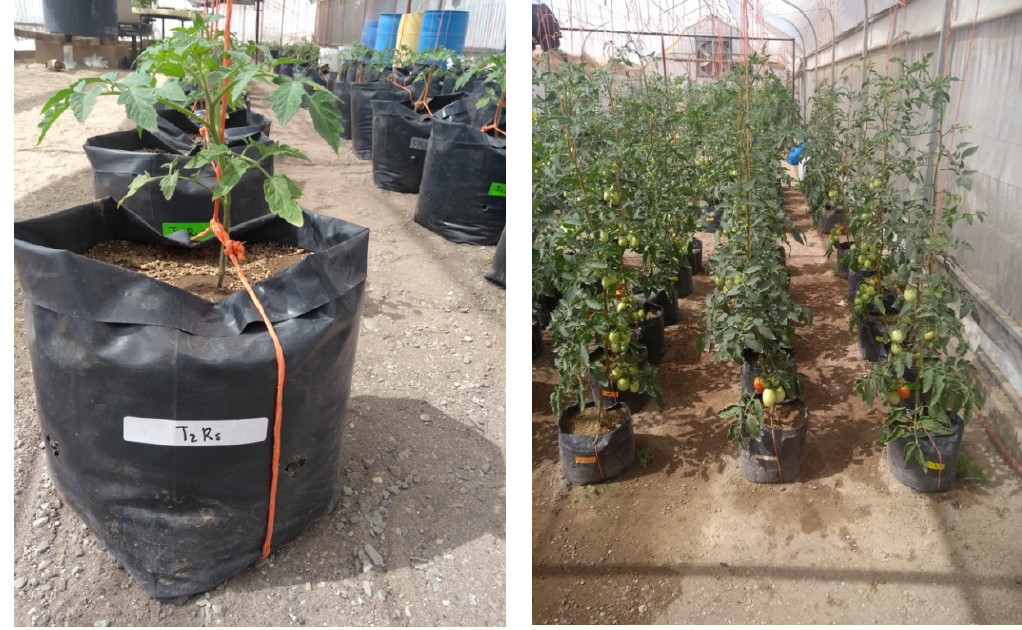
Figure 1. Sahel hybrid tomato plants under greenhouse conditions; Technological Institute of Torreón,